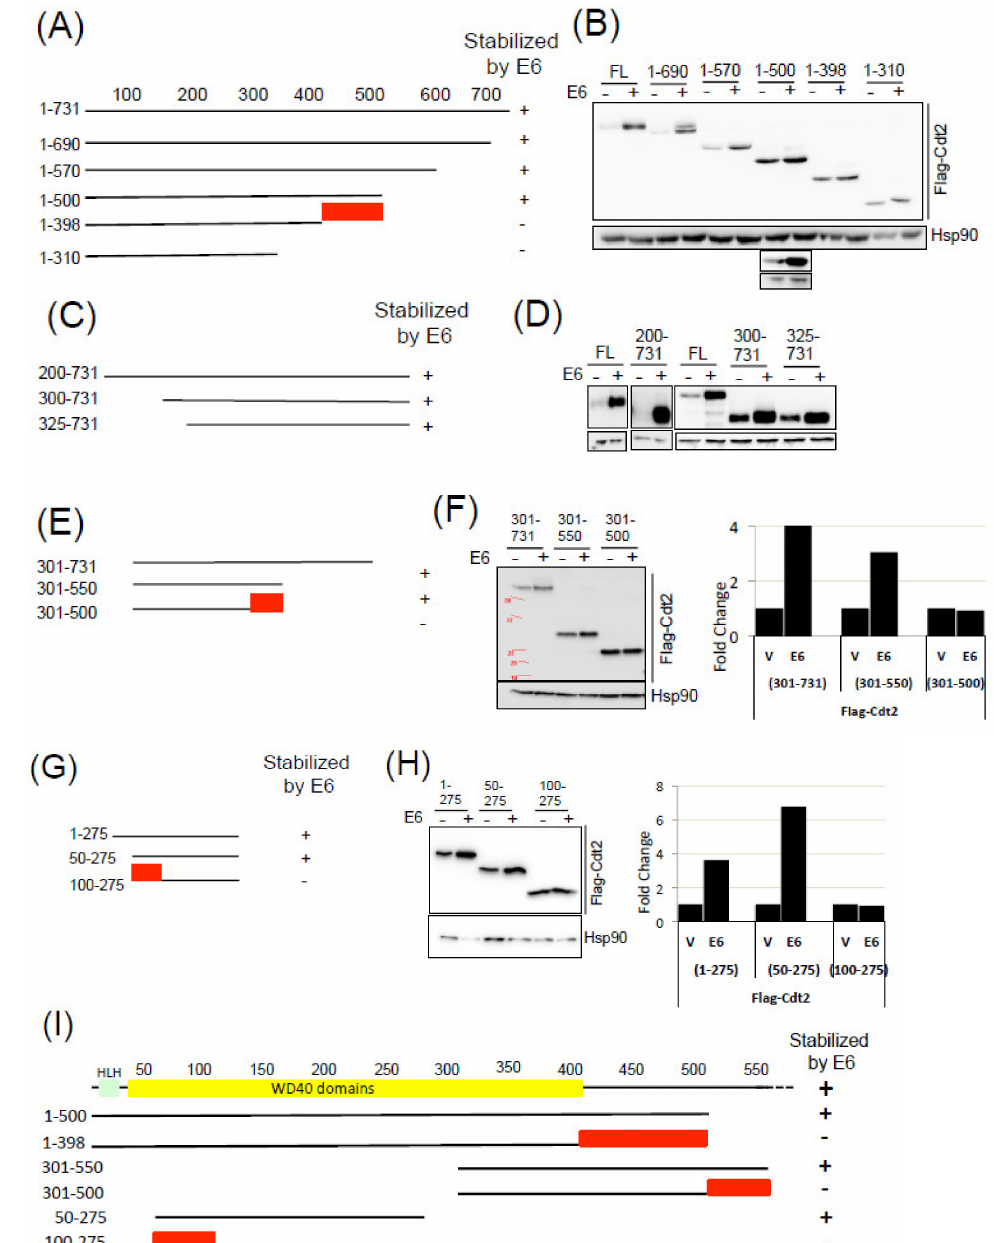
Figure 5. Schematic on the left ( A , C , E , G ) indicate Cdt2 sequences being tested for stabilization by HPV-E6 on the right. ( B , D , F , H )- Indicated Cdt2 deletion constructs were transfected in U2OS cells with control or HPV-E6 expressing vectors and cells were collected 48 h after transfection. Cell lysates were then immunoblotted with indicated antibodies. A separate set of results is presented for Cdt2 1–500 construct to show its robust stabilization by E6. ( I ) Schematic summarizing the critical deletions that identified the sequences that promote stabilization of Cdt2 by E6 relative to the locations of the HLH domain (interacts with DDB1) and the WD40 domain. Red boxes: regions necessary to see the stabilization in the various deletion